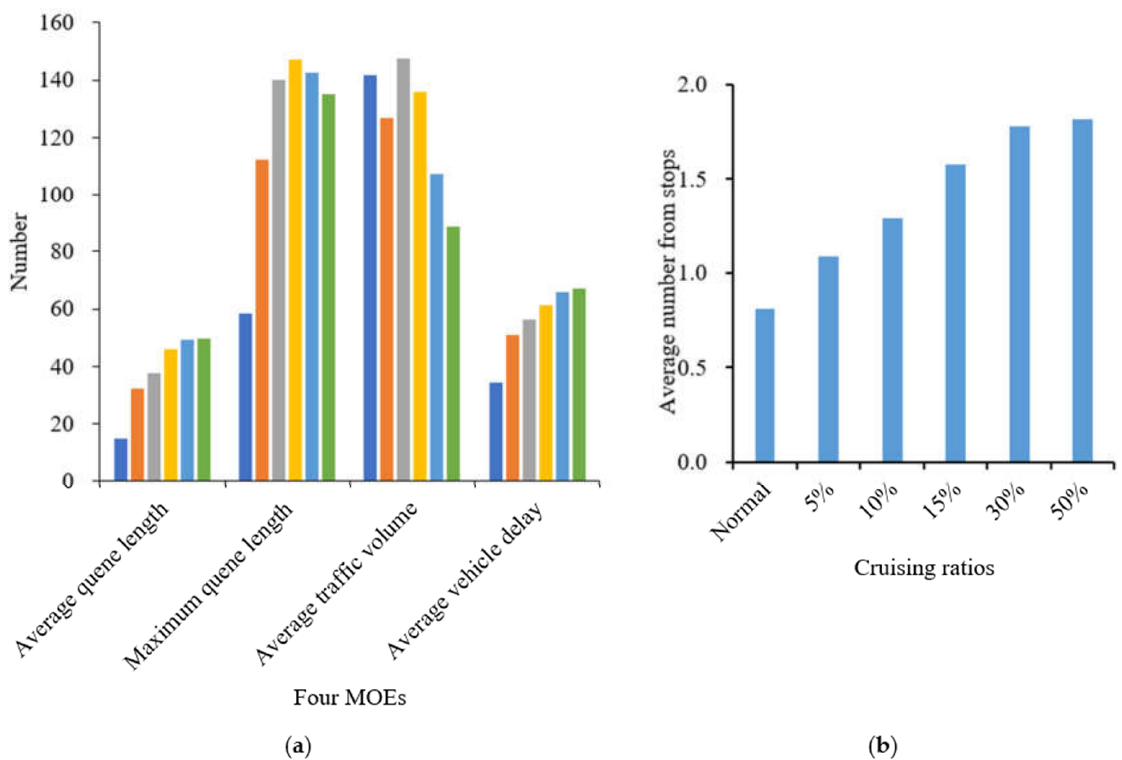
Figure 16. Comparison of five MOEs at road network. ( a ) Four MOEs at road network. ( b ) Average number from stops at road network.